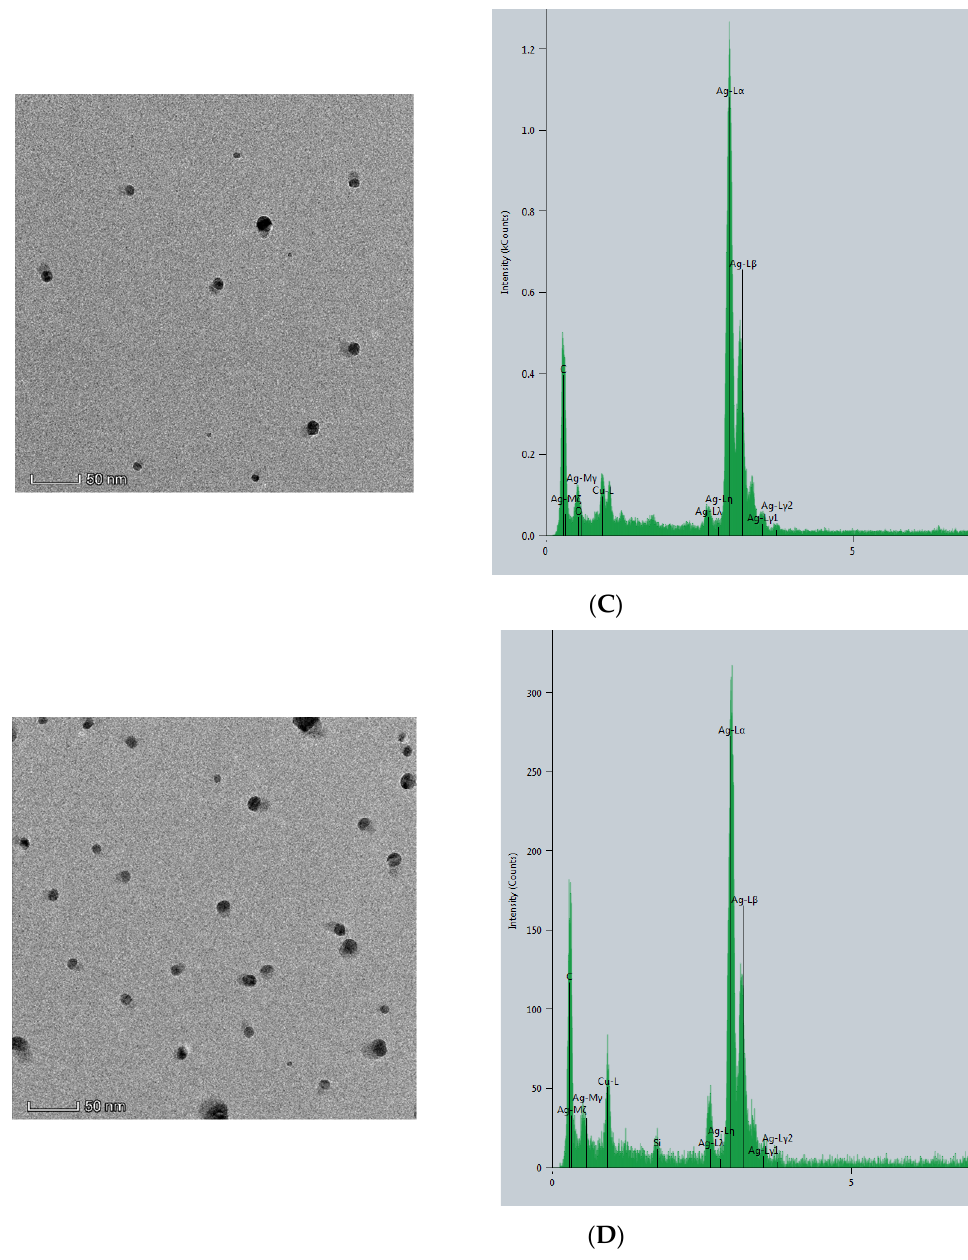
Figure 2. Transmission electron microscope of AgNPs and CB@AgNPs. ( A ): CB@AgNPs; ( B ): AgNPs; ( C ): 0.667 nmol/L Apt Pb +73.98 μ mol/L NaAc-HAc+1.33 μ mol/L CB +1.33 mmol/L AgNO 3 +0.1 mol/L Fo; ( D ): C+0.133nmol/L Pb 2+ .